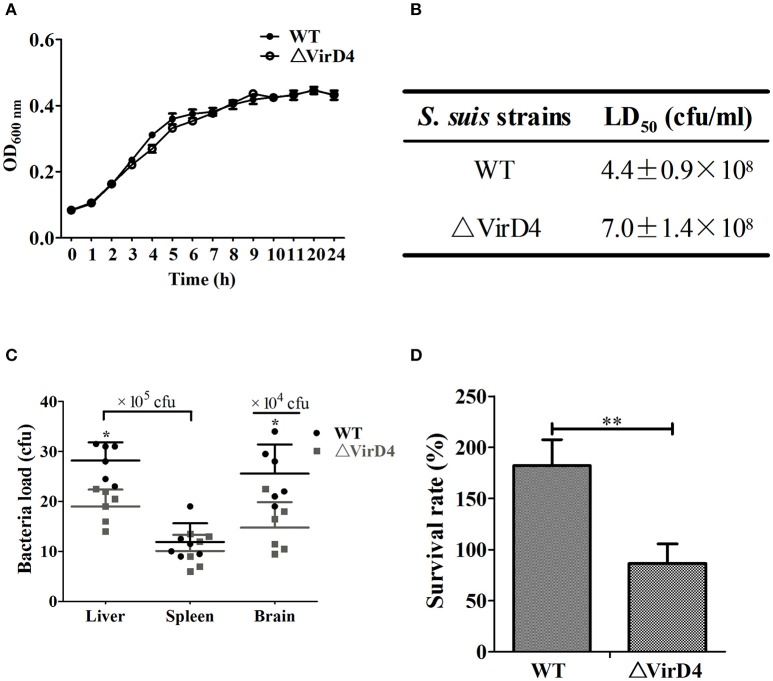
The ΔVirD4 mutant was less virulent than the wild-type strain. (A) Growth curves of the wild-type (WT) S. suis type 2 strain HA9801 and ΔVirD4 mutant. Both strains were cultured in BHI broth and optical density was measured over a 12-h period. (B) 50% lethal dose of WT and ΔVirD4 strains. Different levels of bacteria were intraperitoneally inoculated into BALB/c mice and observed for mortality over a 1-week period. (C) Bacterial load in mice organs (n = 6) at 12 h after sublethal intraperitoneal infection with WT and ΔVirD4 strains. Each point represents a single sample. (D) Survival of WT and ΔVirD4 strains in mice blood for 1 h. Data were shown as mean ± SD of three repeated experiments, each in triplicate tubes, * at P < 0.05 or **P < 0.01.